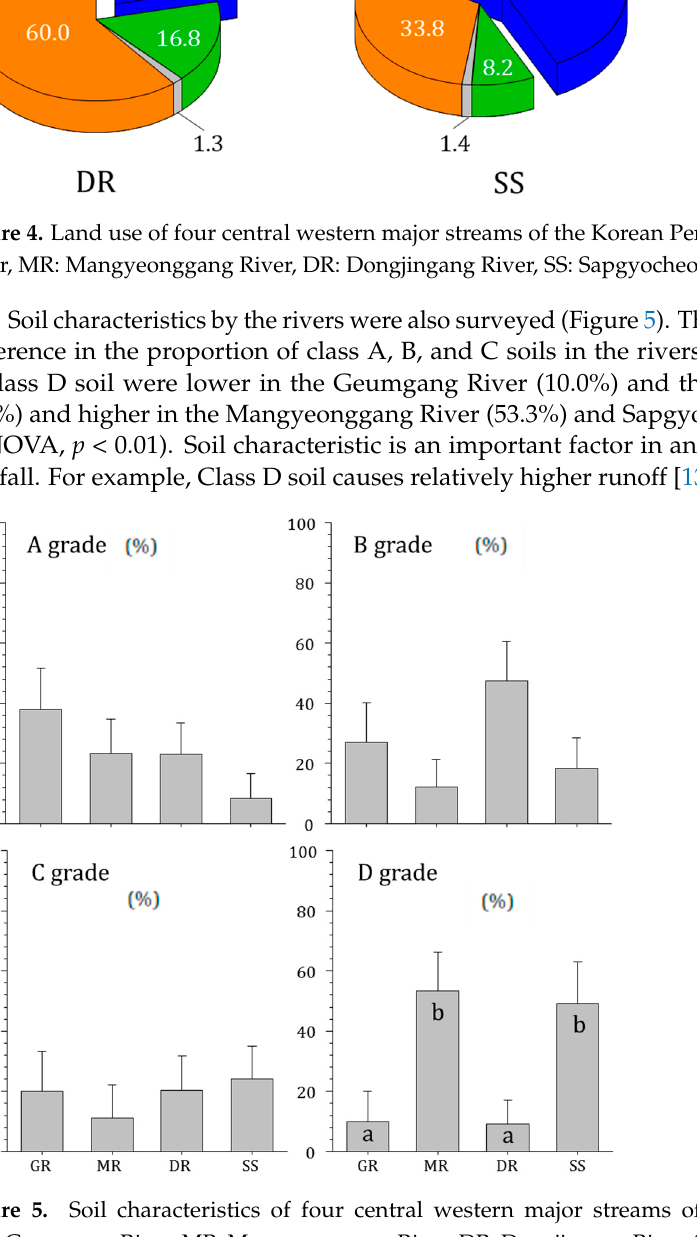
Figure 5. Soil characteristics of four central western major streams of the Korean Peninsula (GR: Geumgang River, MR: Mangyeonggang River, DR: Dongjingang River, SS: Sapgyocheon stream). Small alphabets (a, b) was Tukey’s post hoc test.